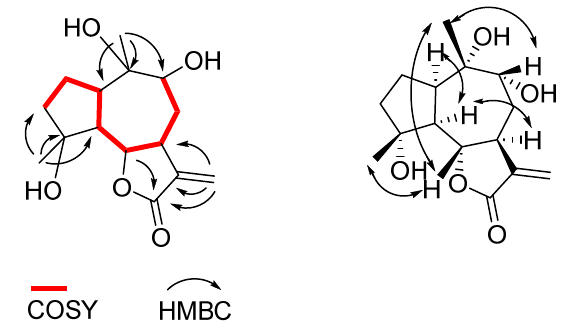
Figure 2. Some key two-dimensional (2D) NMR correlations of 1 (left, correlated spectroscopy (COSY) and heteronuclear multiple bond coherence (HMBC) and right, nuclear Overhauser enhancement spectroscopy (NOESY)).